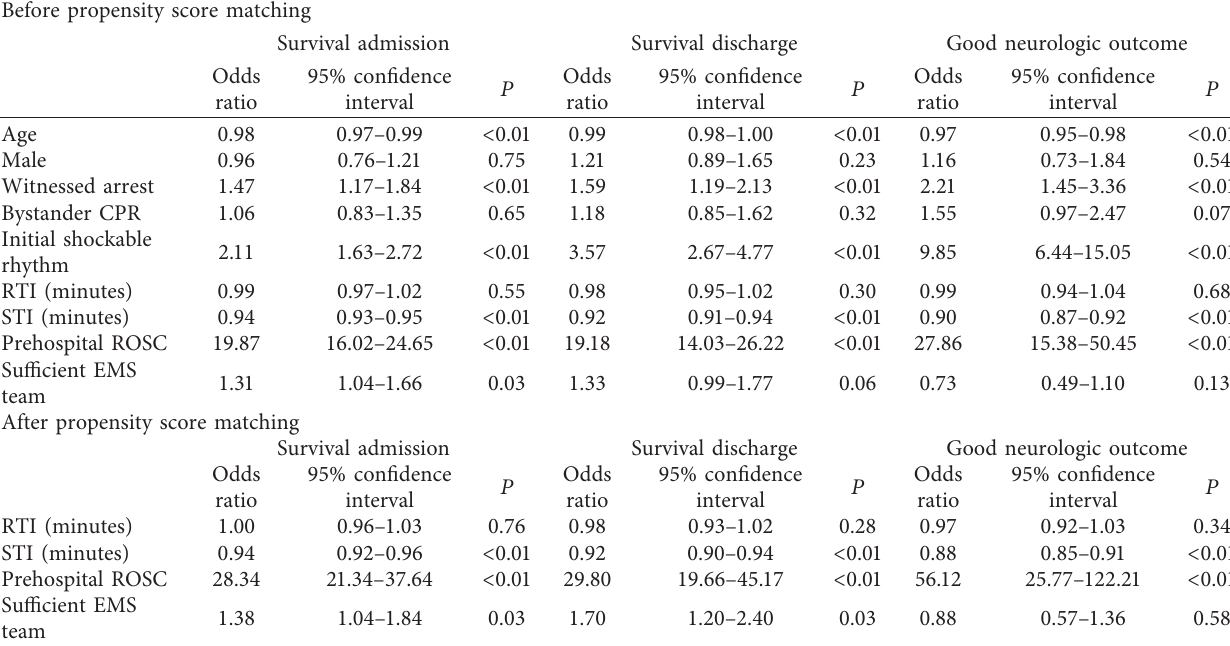
Table 3: Multivariable logistic regression analyses of the variables associated with outcomes before and after propensity score matching. Before propensity score